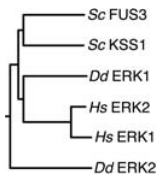
Figure 2 Dendogram of selected ERKs from Dictyostelium dis- coideum ( Dd ), yeast ( Saccharomyces cerevisiae ; Sc ) and mammals ( Homo sapiens ; Hs ). The dendogram was generated at http://clustalw.genome.ed.jp/ by the neighbor-joining method from a ClustalW alignment. Branch lengths reflect sequence